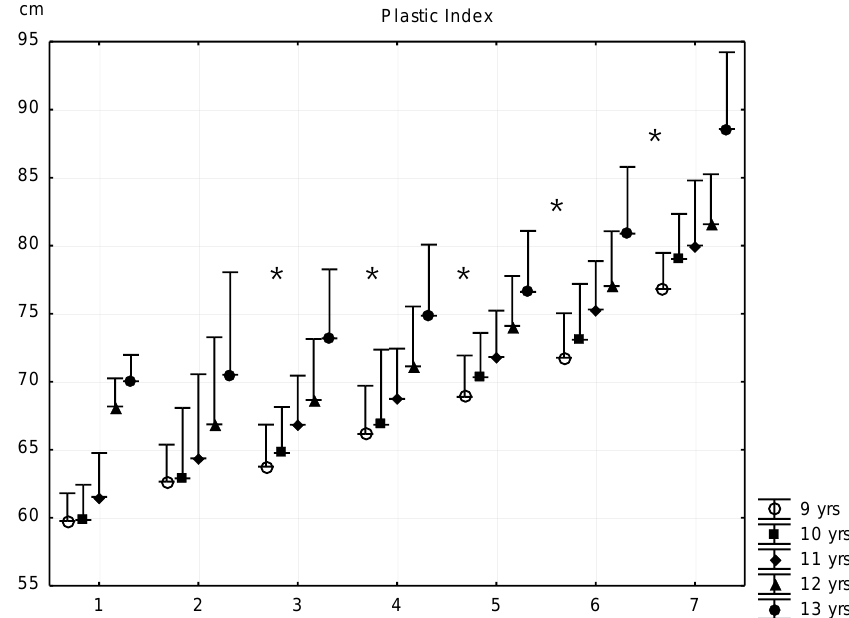
Figure 5. Relationship between body fat percentage and Conrad’s growth type plastic index (mean + SD). 1—F% < 8.00; 2—F% = 8–11.99; 3—F% = 12.00–15.99; 4—F% = 16.00–19.99; 5—F% = 20.00–23.99; 6—F% = 24.00–27.99; 7—F% > 28; F% body fat percentage; * significant difference among subsequent groups, p < 0.05.